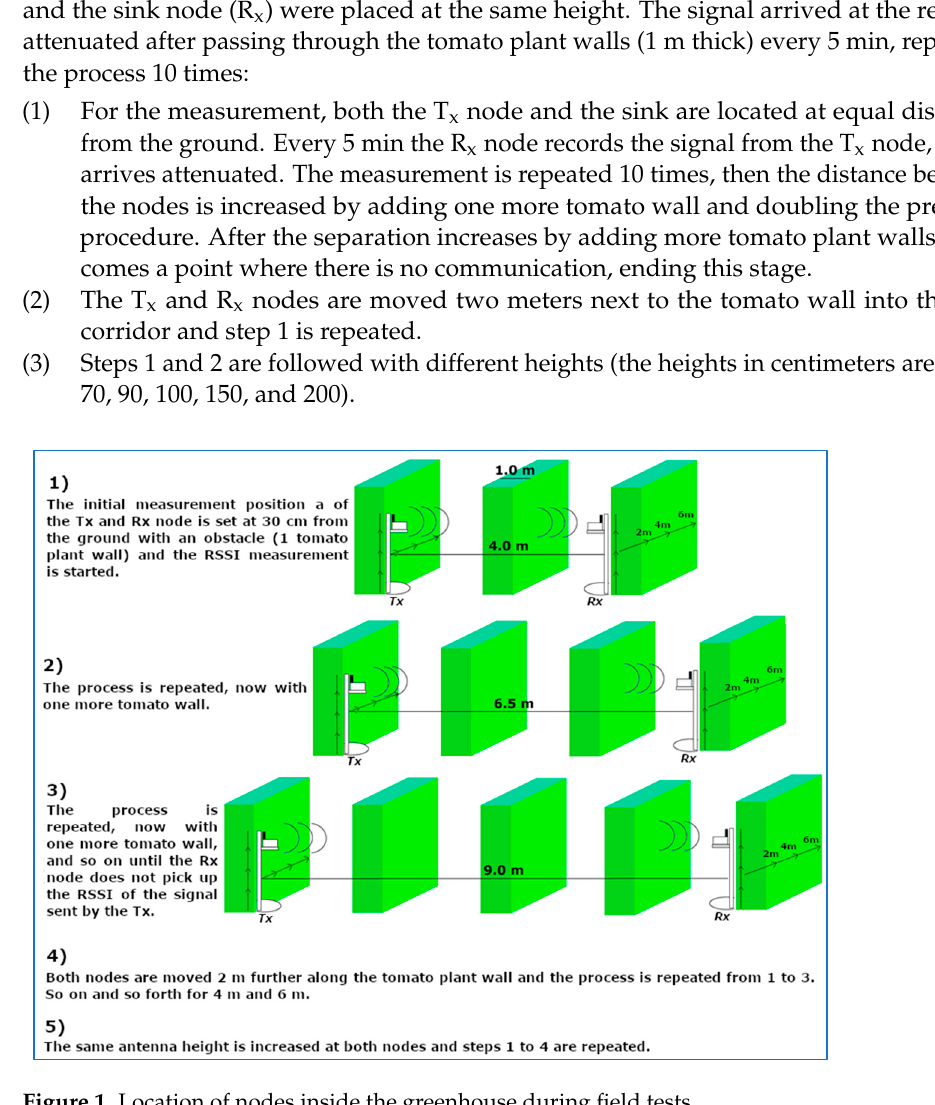
Figure 1. Location of nodes inside the greenhouse during field tests.